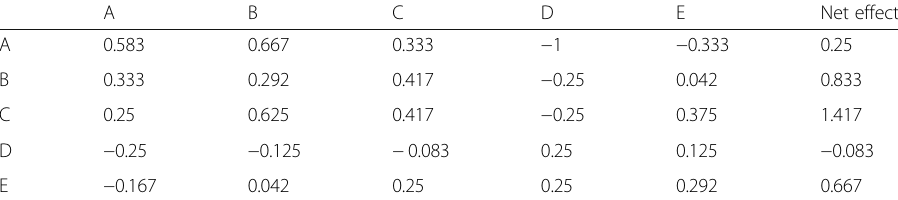
Table 4 Net effect of one node on another up to 2 steps for the toy network shown in Fig. 1. Each cell records the net effect from one node in a particular row on another node in a particular column. The last column records the net effect each node has on the whole network